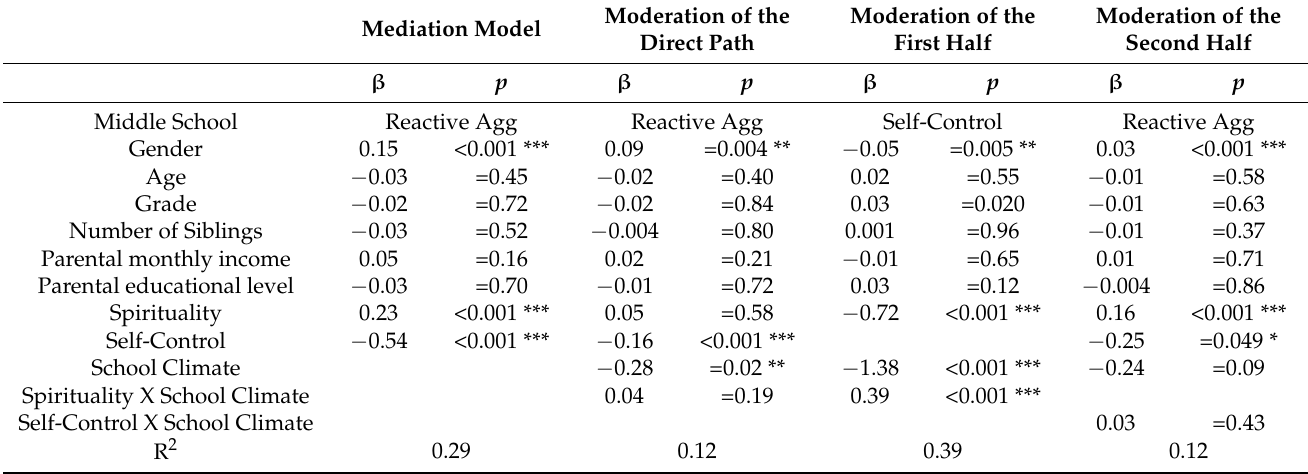
Table 4. Indices of Mediation and Moderation models of the High School Sample.